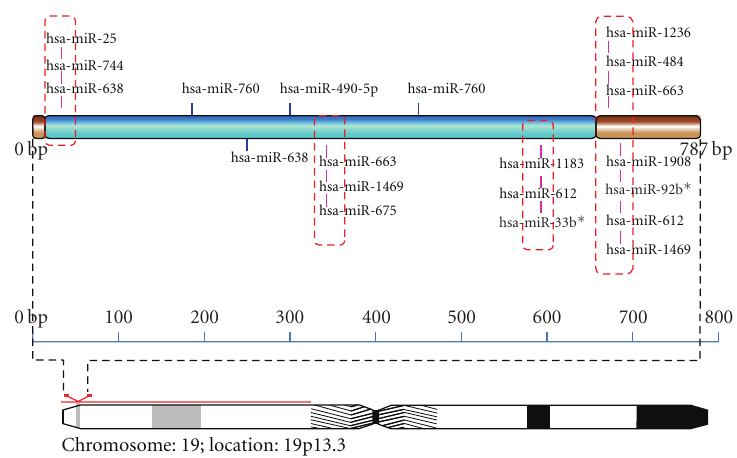
Figure 4: Schematic representation of miRNA targets on NDUFS7.